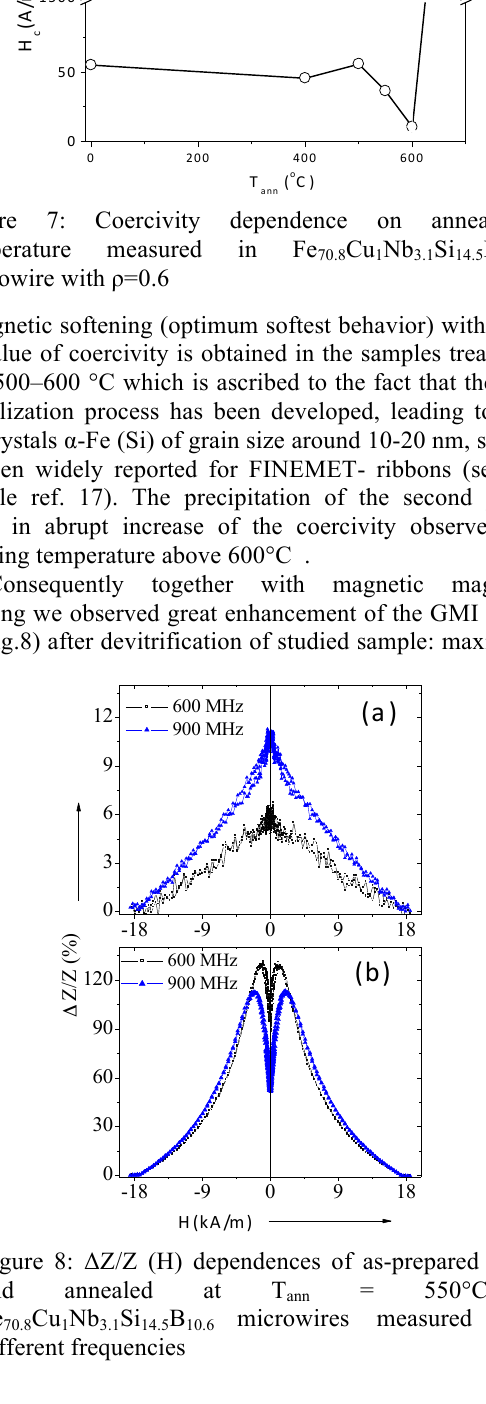
5: Hysteresis loops of